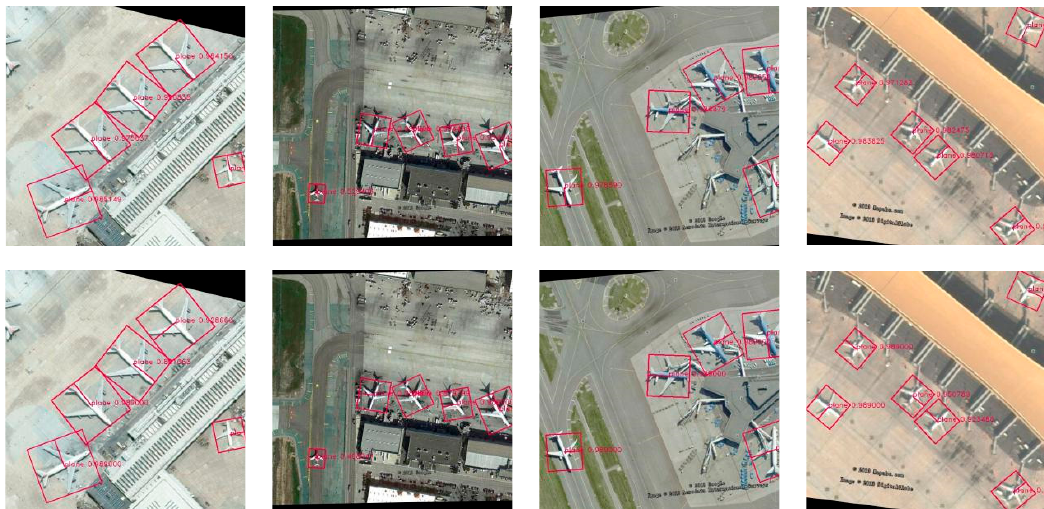
Figure 13. The visual results of plane detection. The first row is the detection results of the proposed algorithm, and the second row is the detection results of the comparison algorithm.